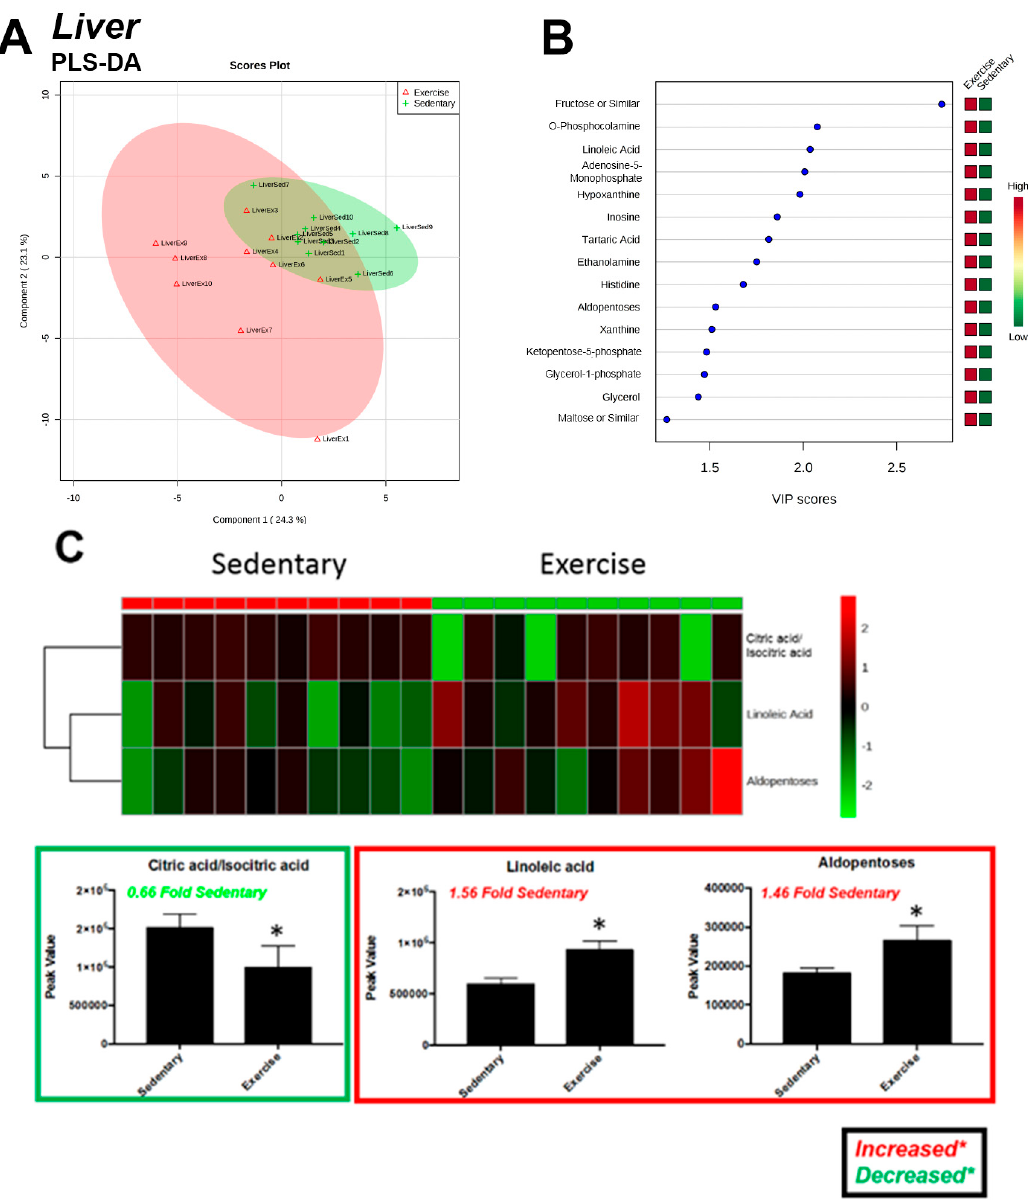
Figure 5. Analysis of non-targeted metabolomics of liver from exercise-trained or sedentary control rats. ( A ) Principal components analysis using PLS-DA. ( B ) Variable importance in projection (VIP) scores. ( C ) Heatmap of t -test significant liver metabolites in exercise-trained rats vs. sedentary. Data represent mean ± SEM. * P < 0.05. N = 12/group.